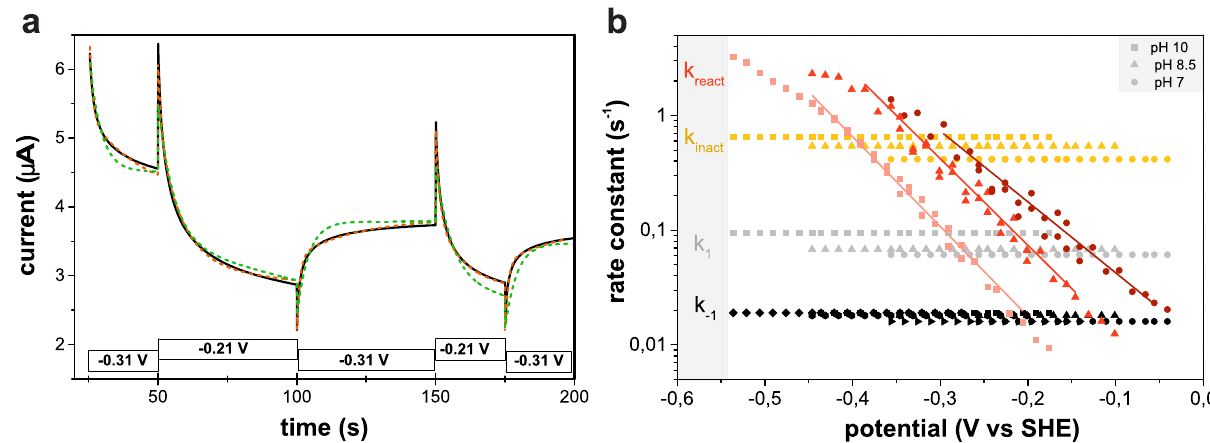
Fig. 4 Anaerobic conversion between active and inactive CbA5H WT monitored by PFE. a Chronoamperograms recorded to analyze the kinetics of anaerobic (in)activation of CbA5H WT by stepping between − 0.31 and − 0.21 V. The boxes along the abscissa depict the sequence of applied potential steps and the corresponding current response (black line). The plot also shows the best fi ts of models that consider the interconversion between two (green dotted line) or three (red dotted line) species. Experimental parameters: 5 °C, pH 7, 3000 rpm. b Dependence of the rate constants of the “ AAI ” model (A1 ↔ A2 ↔ H inact ) on potential and pH, based on the analyses of chronoamperograms recorded for CbA5H WT at pH 10 (squares), 8.5 (triangle), and 7 (circle). Only k react signi fi cantly depends on pH and electrode potential. Source data are provided in a source data fi le.